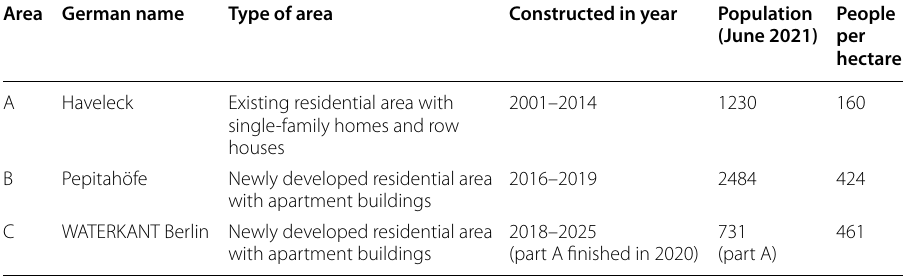
Table 1 Information on the three study